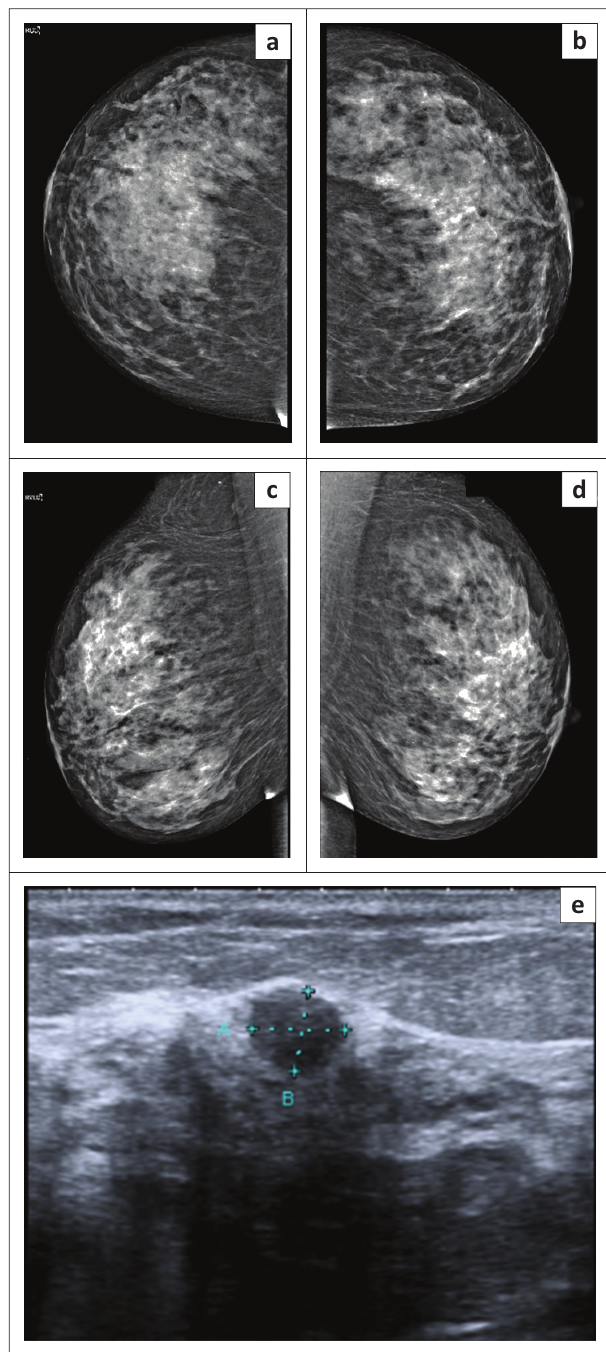
FIGURE 3: (a–d) Normal appearing craniocaudal and mediolateral mammogram views and (e) right breast sonar image revealing a benign-appearing nodule.